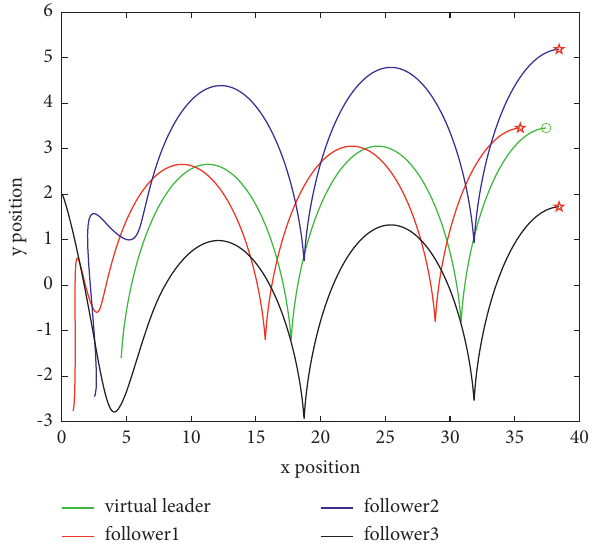
Figure 5: The extended state estimation error 􏽥 x i, 3 in Case A. (a) The disturbance estimation error of the x -direction of the i th agent i (b) The disturbance estimation error of the y -direction of the i th agent i � 1, 2, 3.